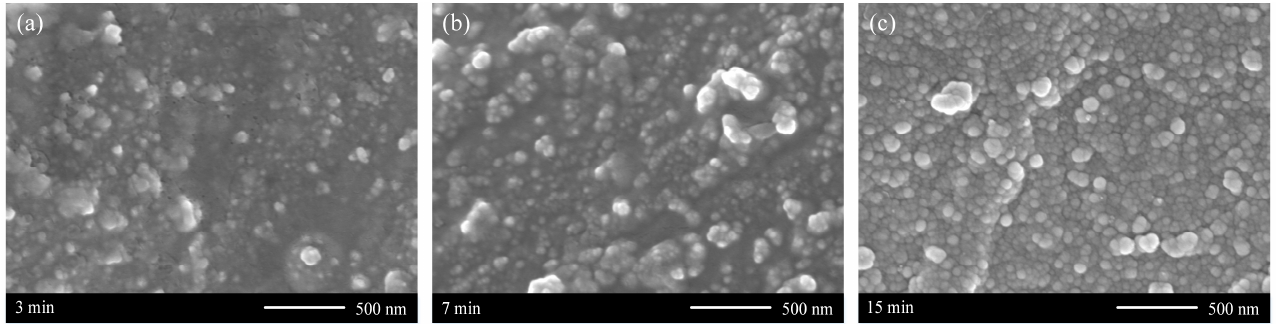
Figure 5. SEM images showing growth process diagram of Ni-P alloy: ( a ) 3 min after electroless deposition; ( b ) after 7 min; ( c ) after 15 min.